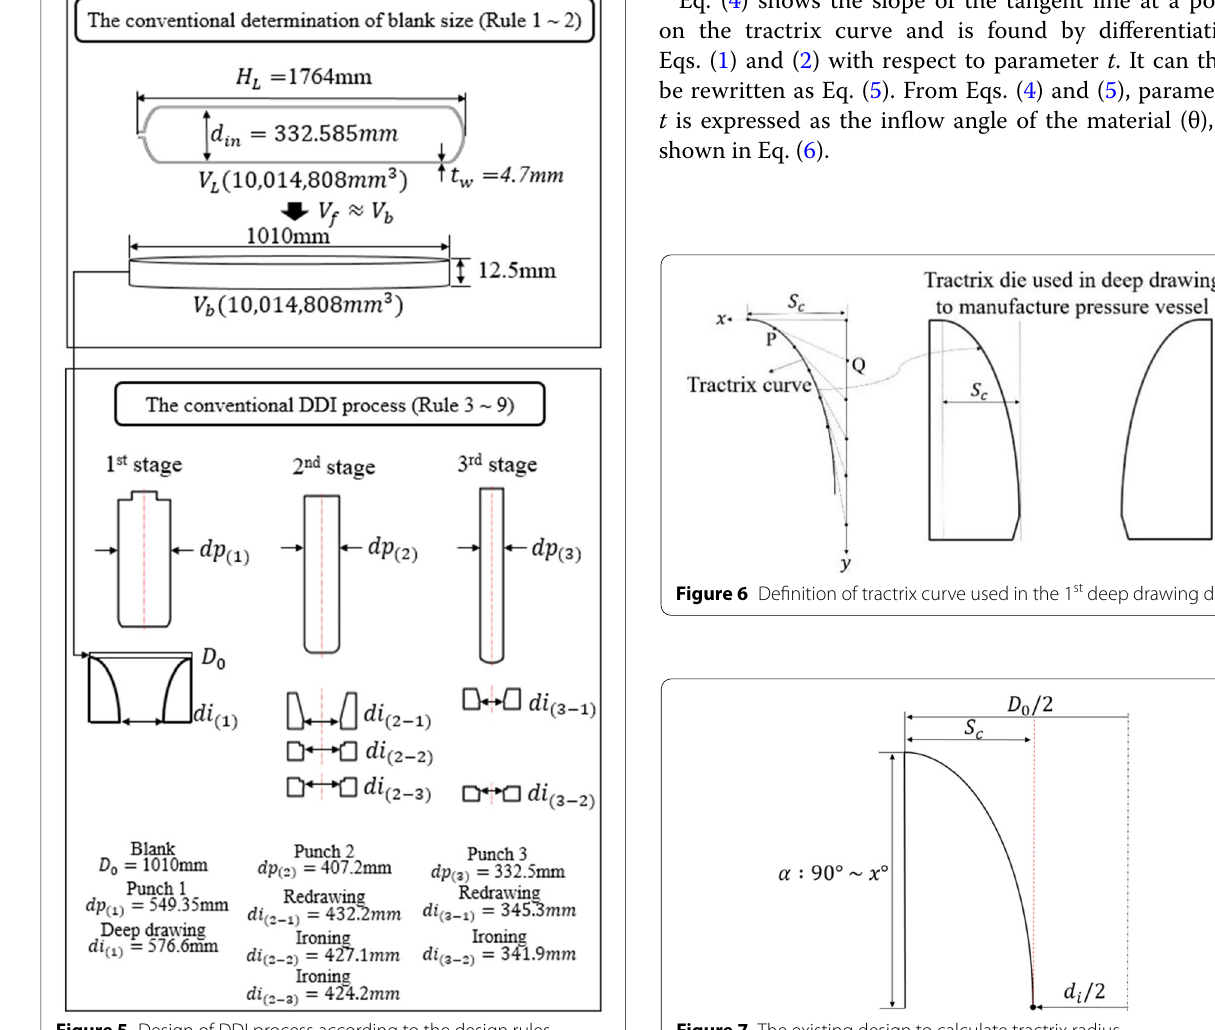
Figure 5 Design of DDI process according to the design rules